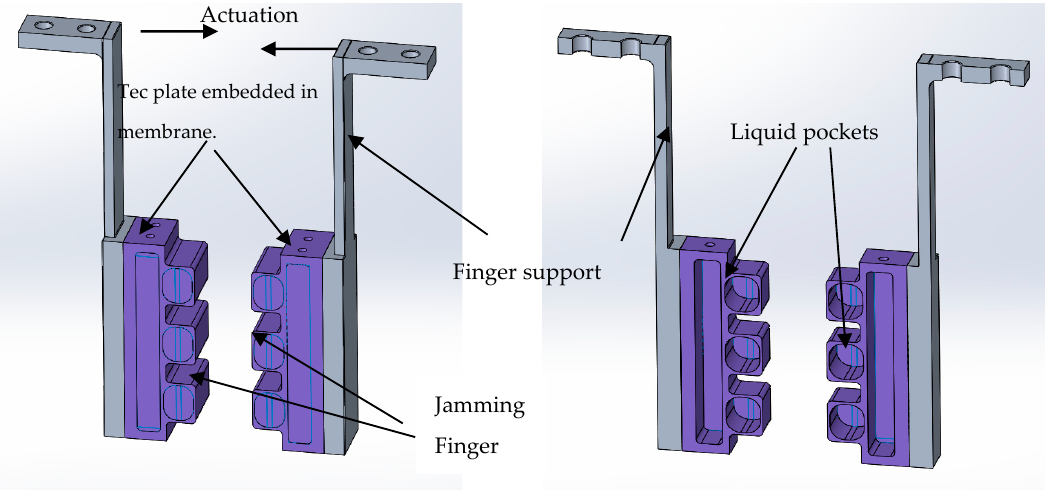
Figure 13. Two-finger gripper design with liquid jamming pockets.